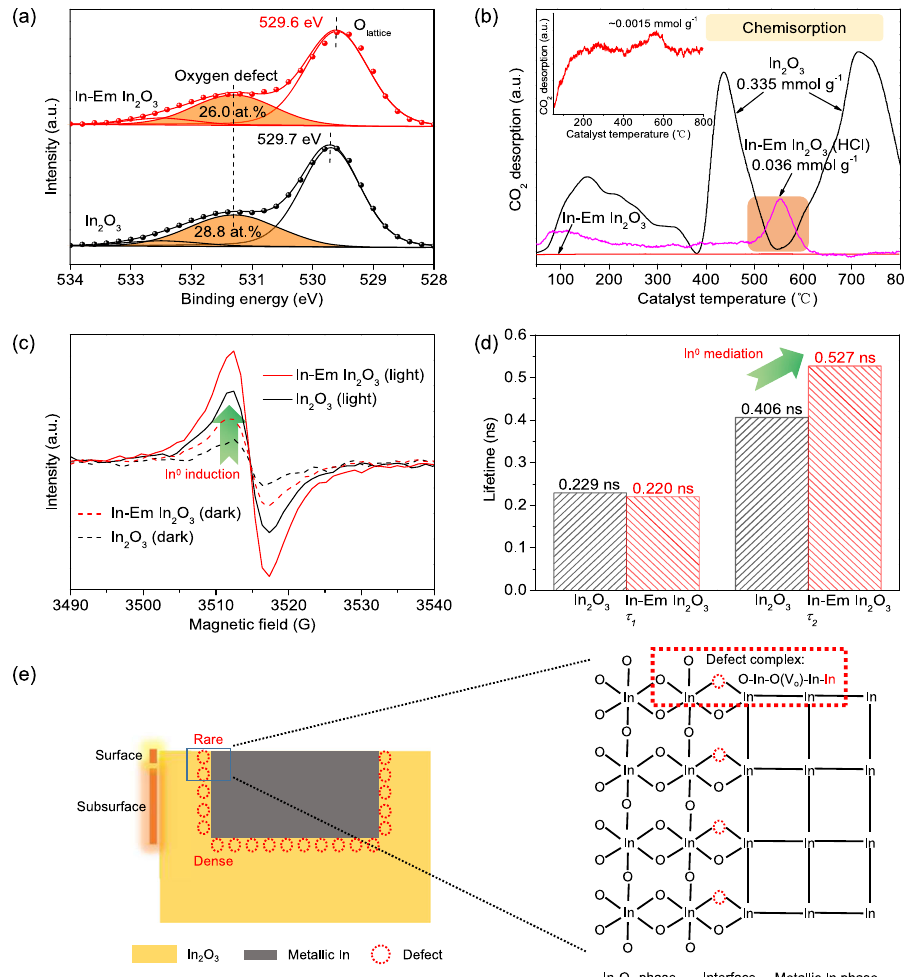
Fig. 2 Identi fi cation of oxygen defects. a O 1s XPS spectra of In 2 O 3 and In-Em In 2 O 3 . b CO 2 -TPD pro fi les of In 2 O 3 , In-Em In 2 O 3 , and In-Em In 2 O 3 (HCl) with HCl etching. c ESR spectra of In 2 O 3 and In-Em In 2 O 3 at 100 K in the dark and under light irradiation. d Lifetimes ( τ ) of positrons in PAS spectra of In 2 O 3 and In-Em In 2 O 3 . e Model of distribution and structure of oxygen defects of In-Em In 2 O 3